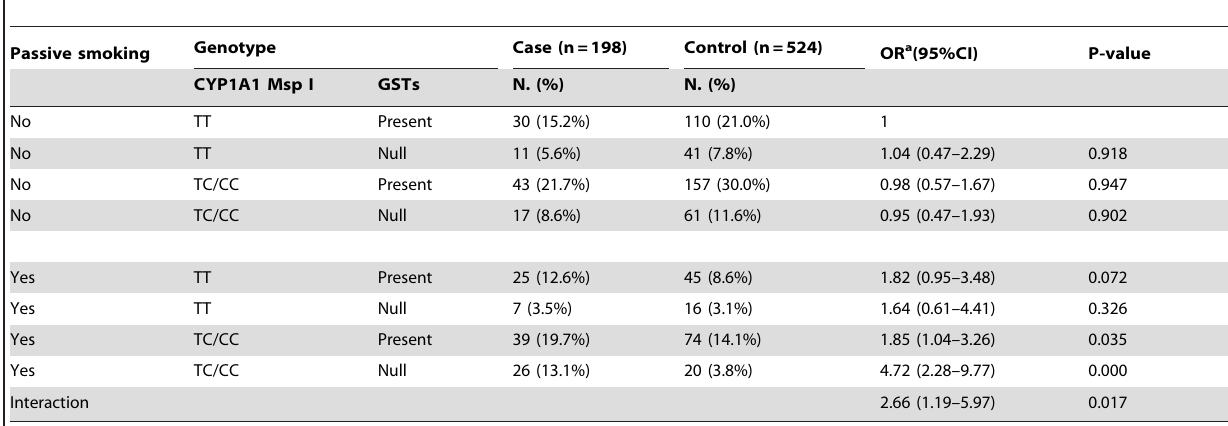
Table 4. Interaction between maternal passive smoking during pregnancy and joint genotype of CYP1A1 Msp I and GSTs on risk of spontaneous PTD.